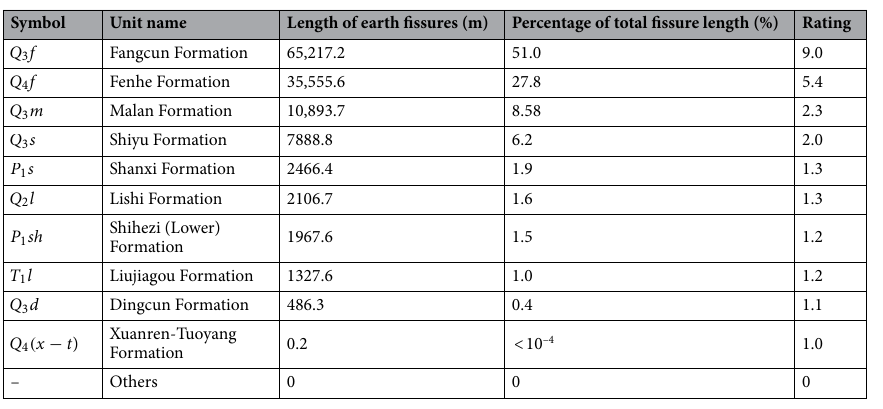
Table 3. Ratings of geologic